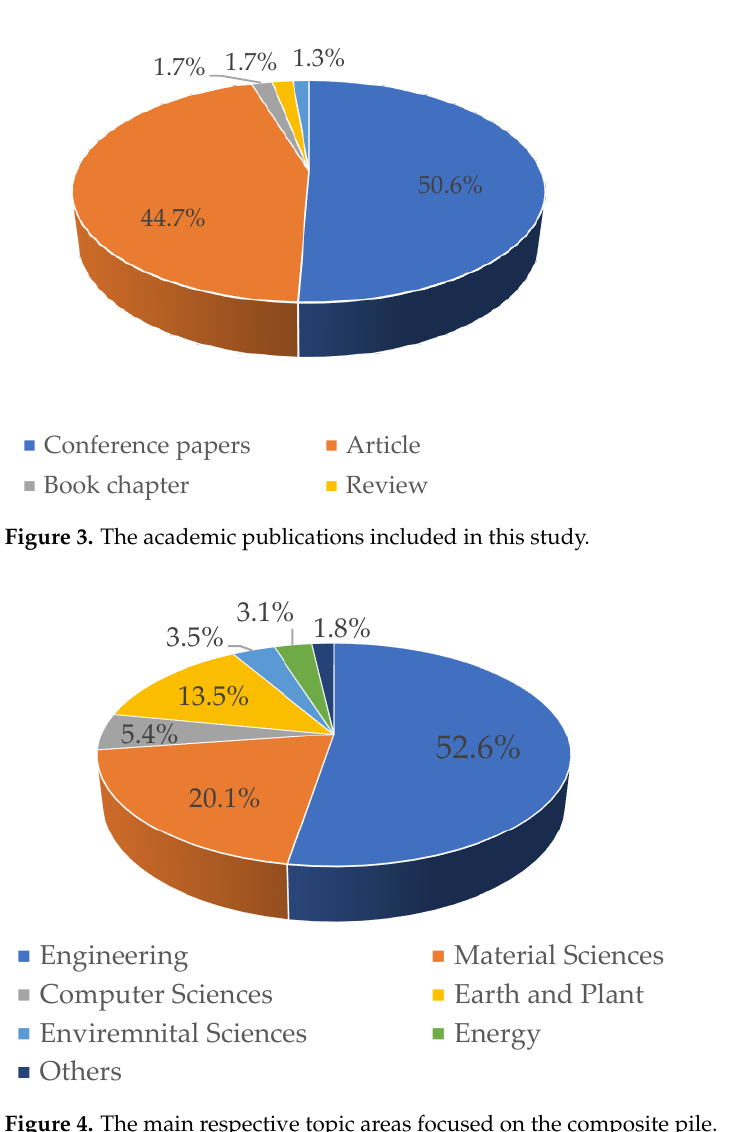
Figure 4. The main respective topic areas focused on the composite pile.